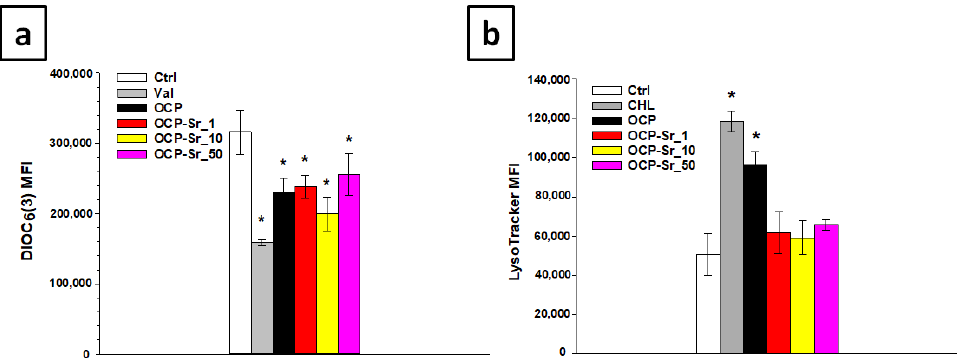
Figure 6. Mitochondrial membrane potential ( a ), quantitative assessment of the fluorescence intensity of acid compartments ( b ). Ctrl—untreated cells without the addition of calcium phosphate compounds. Val is valinomycin. CHL—chloroquine. MFI—Mean fluoresce intensity. *—statistically significant difference compared to untreated control cells, p < 0.05.